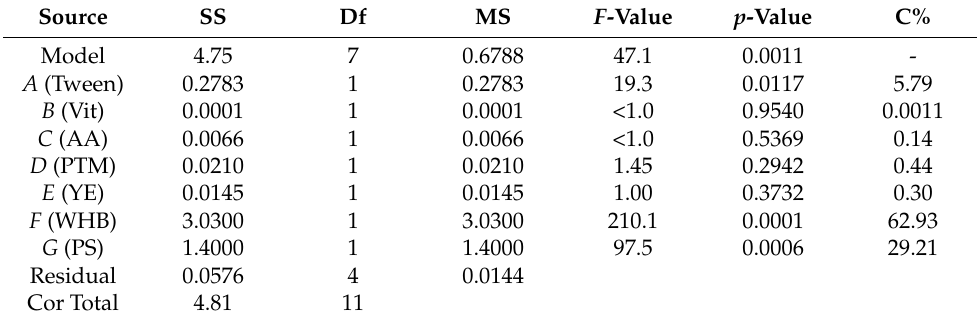
Table 2. Statistical analysis of the PBD